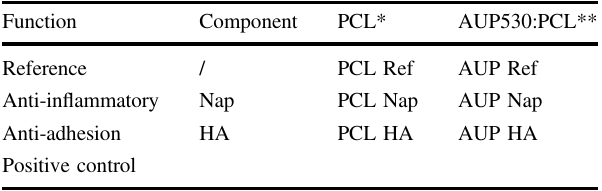
Table 1 Overview of electrospun materials (PCL and AUP530:PCL) with or without additional components during in vitro (in)direct cell tests Function Component